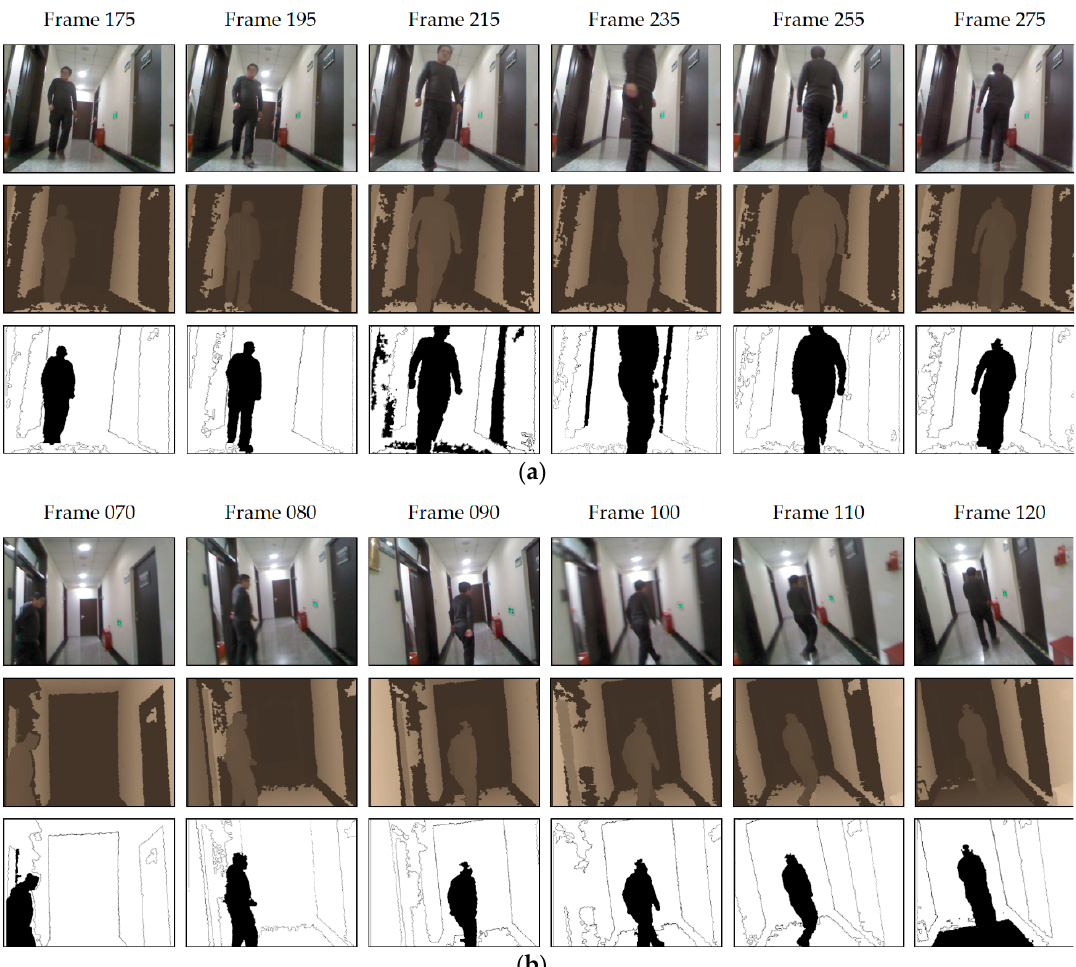
Figure 11. Some experimental results of the proposed method using sequence images captured in a corridor environment. ( a ) RGB-D camera was fixed and the experimenter approached the camera and then turned away from it; ( b ) RGB-D camera swung from side to side and the experimenter just walked away from the camera plane. The moving objects detected by our method are colored in black, as shown in the third row of each